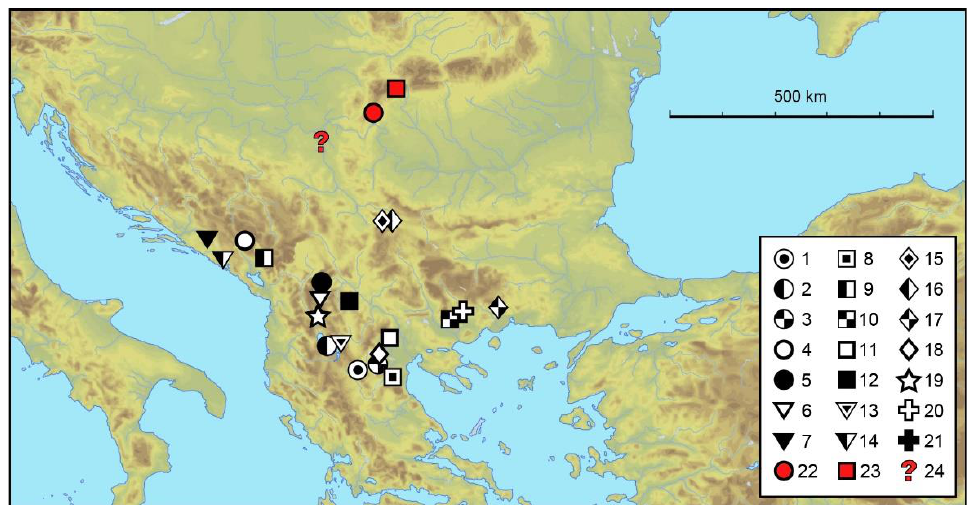
Figure 5. Distribution map of genera Winklerites and Dicropterus . 1: W. andreae ; 2: W. blazeji ; 3: W.